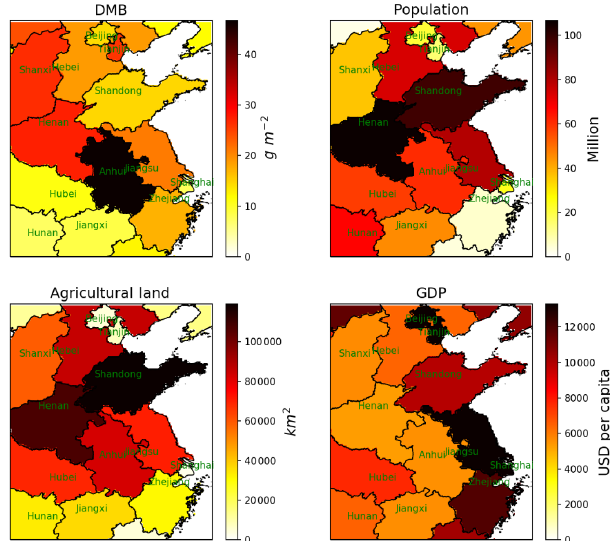
Figure 12. Spatial distribution of province-specific (a) mean annual dry matter burned as calculated using the VIIRS-IM/Him approach developed herein, (b) population (data source: Fu et al., 2014a), (c) agricultural land area (data source: GlobeLand30, http://www. globallandcover.com/, last access: 4 August 2020), and (d) mean GDP per capita (data source: Fu et al., 2014b). The basic layer of country–province borders within this map was created using the Python Basemap library.